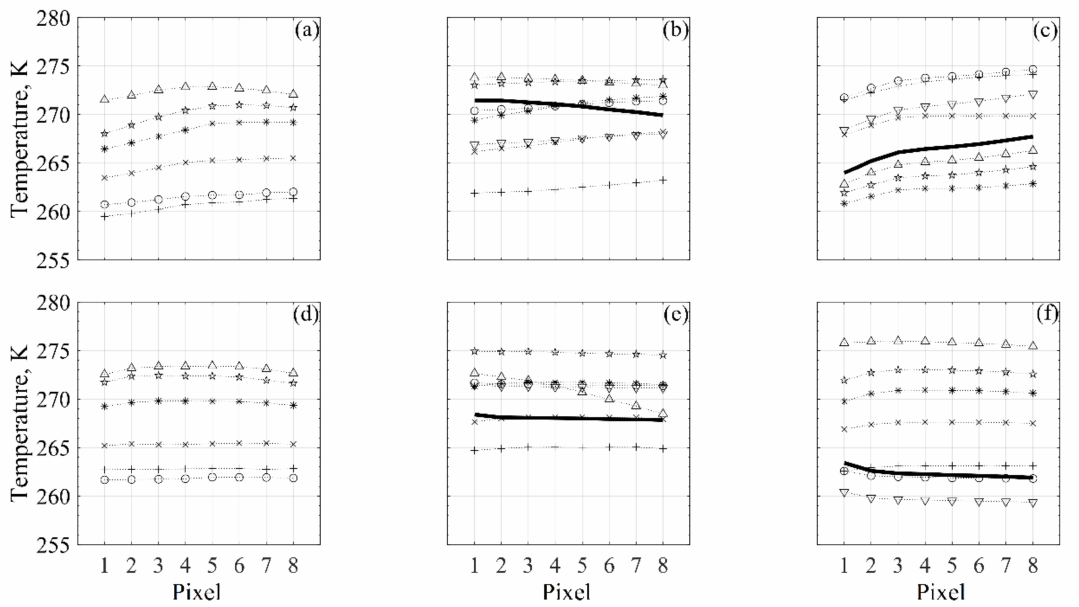
Figure A3. Vertical temperature gradients and possible profile inversions for sucrose 5%. Top graphs ( a – c ) are ON-shelf, while bottom graphs ( d – f ) are OFF-shelf. ( a , d ) Spontaneous nucleation, ( b , e ) VISF 271 K, ( c , f ) VISF 263 K. Each line represents the temperature gradient in the points of interest, represented by different symbols as shown in Figure A2.